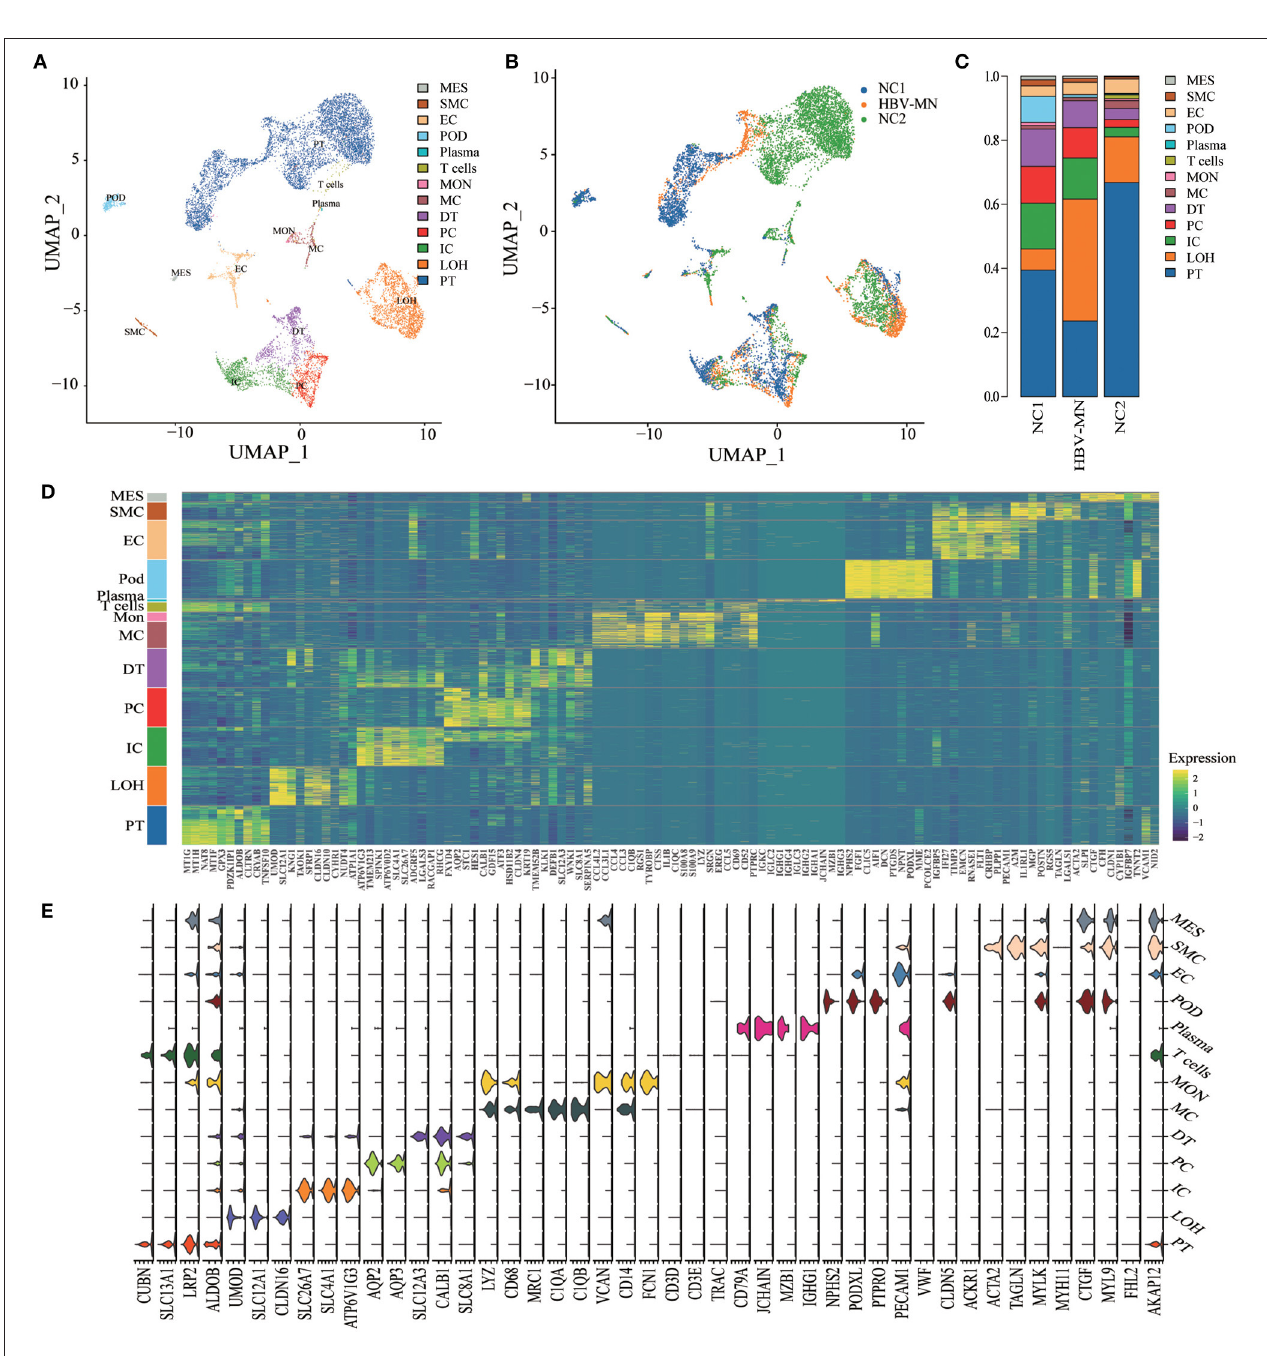
FIGURE 1 | Cell lineage analysis by comprehensive single-cell RNA-sequencing in HBV-MN and healthy subjects. (A) Thirteen distinct cell clusters were visualized by UMAP plotting, with each cell color-coded for its associated subtypes. The color of the cells represents group origin. (B) UMAP plot of cell clusters from different subjects of HBV-MN and healthy subjects. The color of cells reflected the individual origin. (C) Bar plots of the percent contribution of cell clusters in kidneys from different subjects. Blocks represented different subjects, and block height was in proportion to the number of cells. (D) Heatmap of the top 10 most differentially expressed genes in each cluster to identify mutually exclusive gene sets, which were then used to determine the cell lineage of each cluster. Each column represented a cell cluster, and each row corresponded to a marker gene for the individual cluster. Transcript abundance ranges from low (purple) to high (yellow). (E) Violin plot of selected marker genes that identified the clusters generated by UMAP plotting. It was colored by different cell subtypes. PT, proximal tubule cells; LOH, loop of Henle cells; PC, principal cells; IC, intercalated cells; DT, distal tubule cells; EC, endothelial cells; Pod, podocytes; MES, mesangial cell; MC, macrophages; Mon, monocytes; SMC, smooth muscle